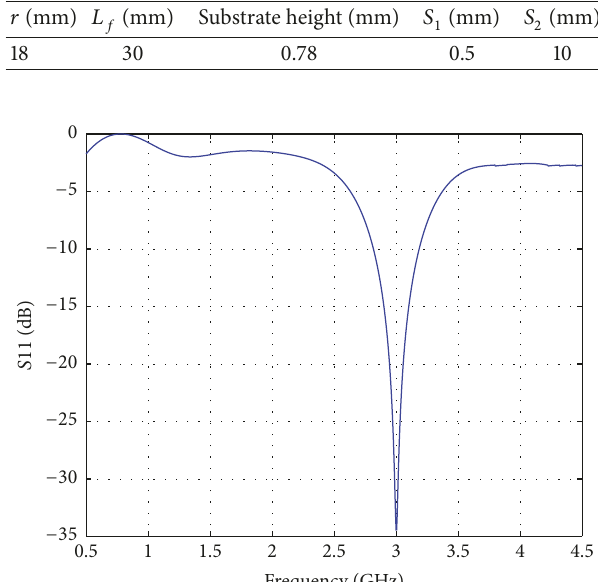
Table 2: Parameters of the microstrip antenna.